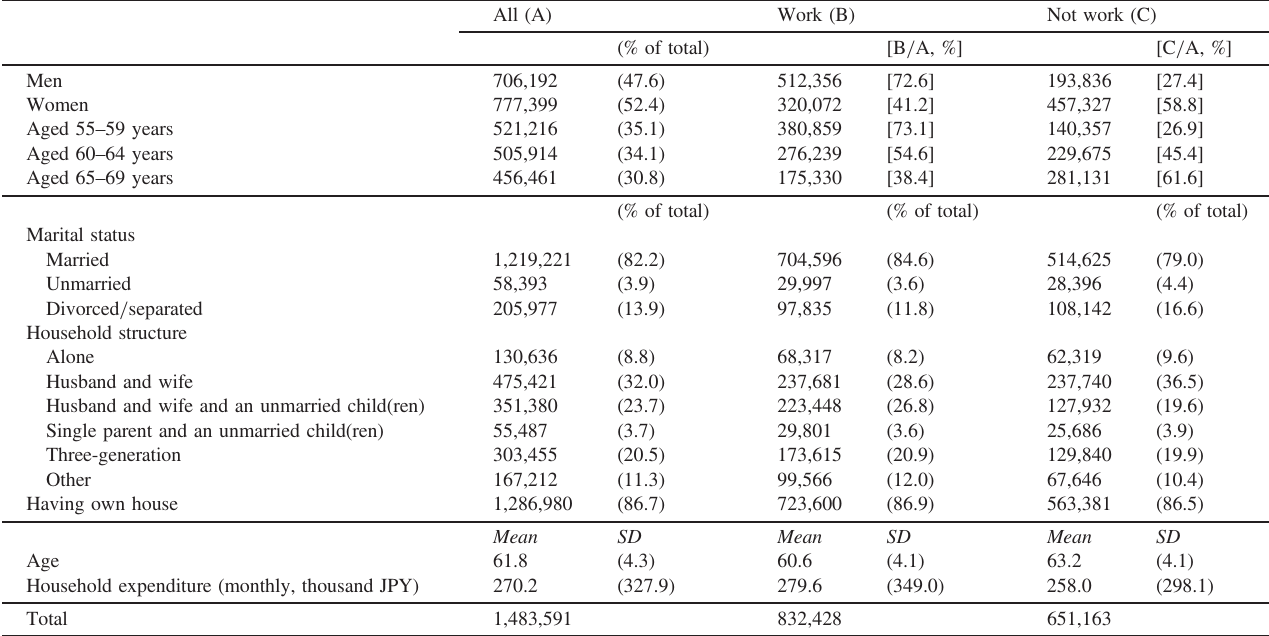
Table 1. Key features of the study sample